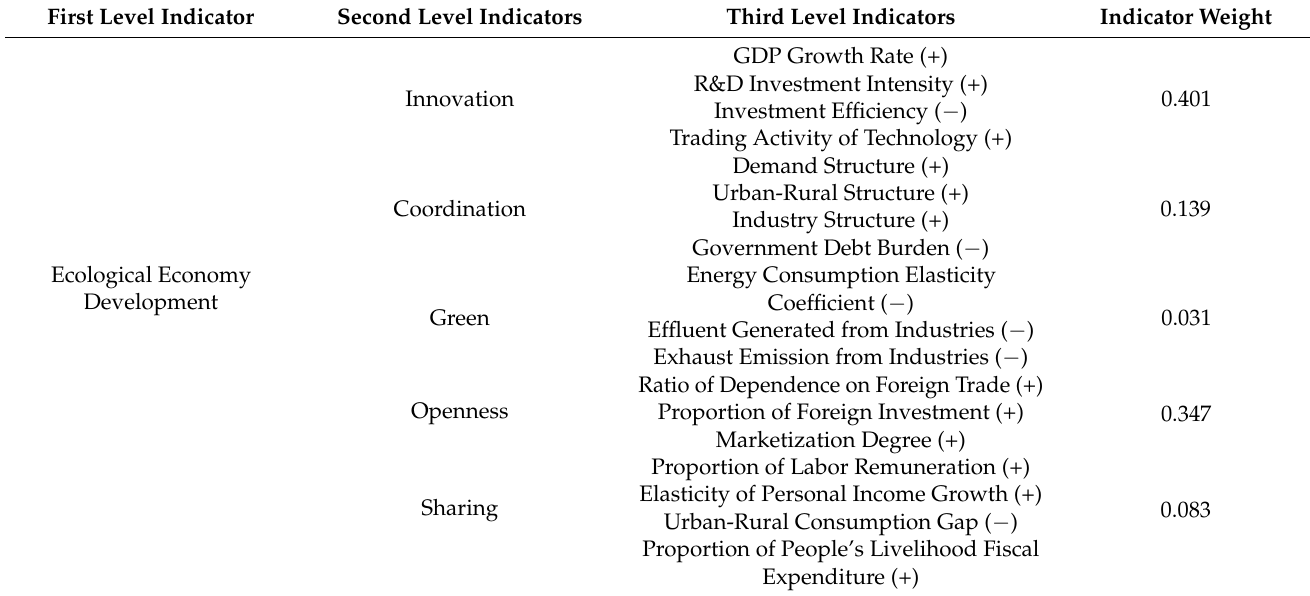
Table 3. Index evaluation system and weight for ecological economy